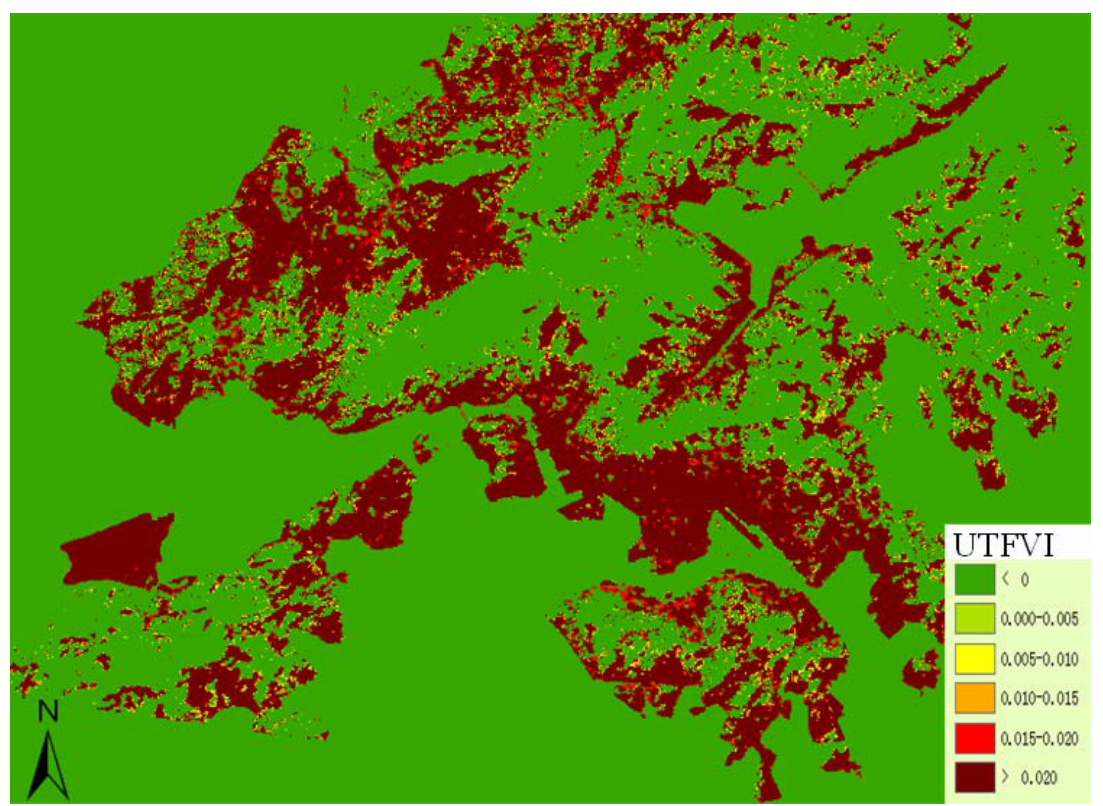
Figure 8. The UTFVI classification map of ecological evaluation in Hong